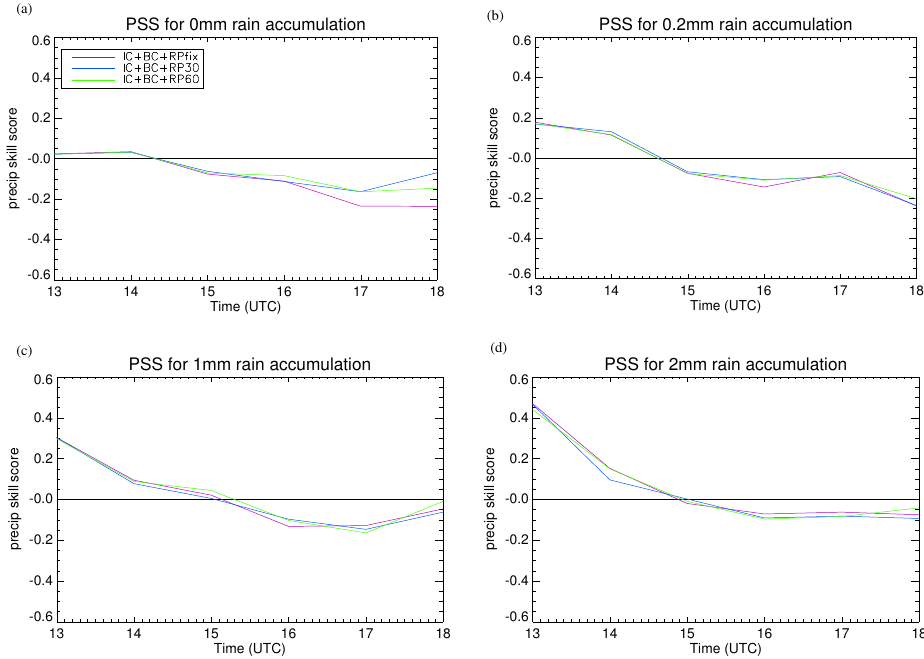
Fig. 18. PSS for hourly rain accumulation for the IC+BC+RP* ensembles with reference to the CTL ensemble for (a) 0mm, (b) 0.2mm, (c) 1mm and (d) 2mm